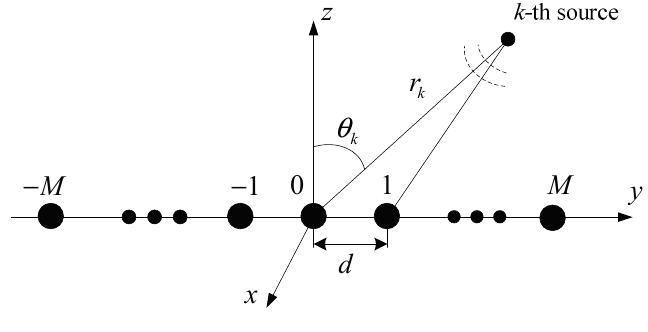
Figure 1. Symmetric uniform linear sensor array (ULSA) configuration for the proposed